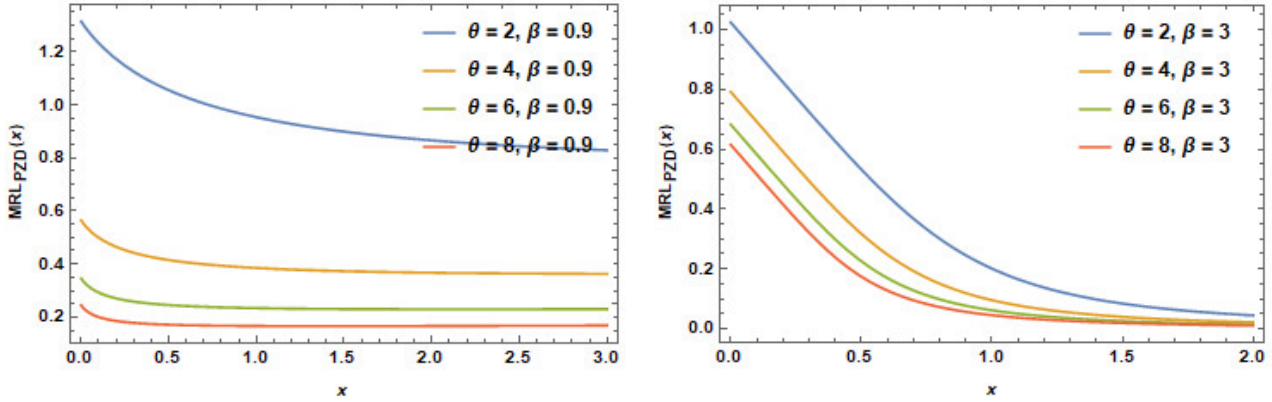
Figure 8. The MRL plots of PZD for selected values of θ , β